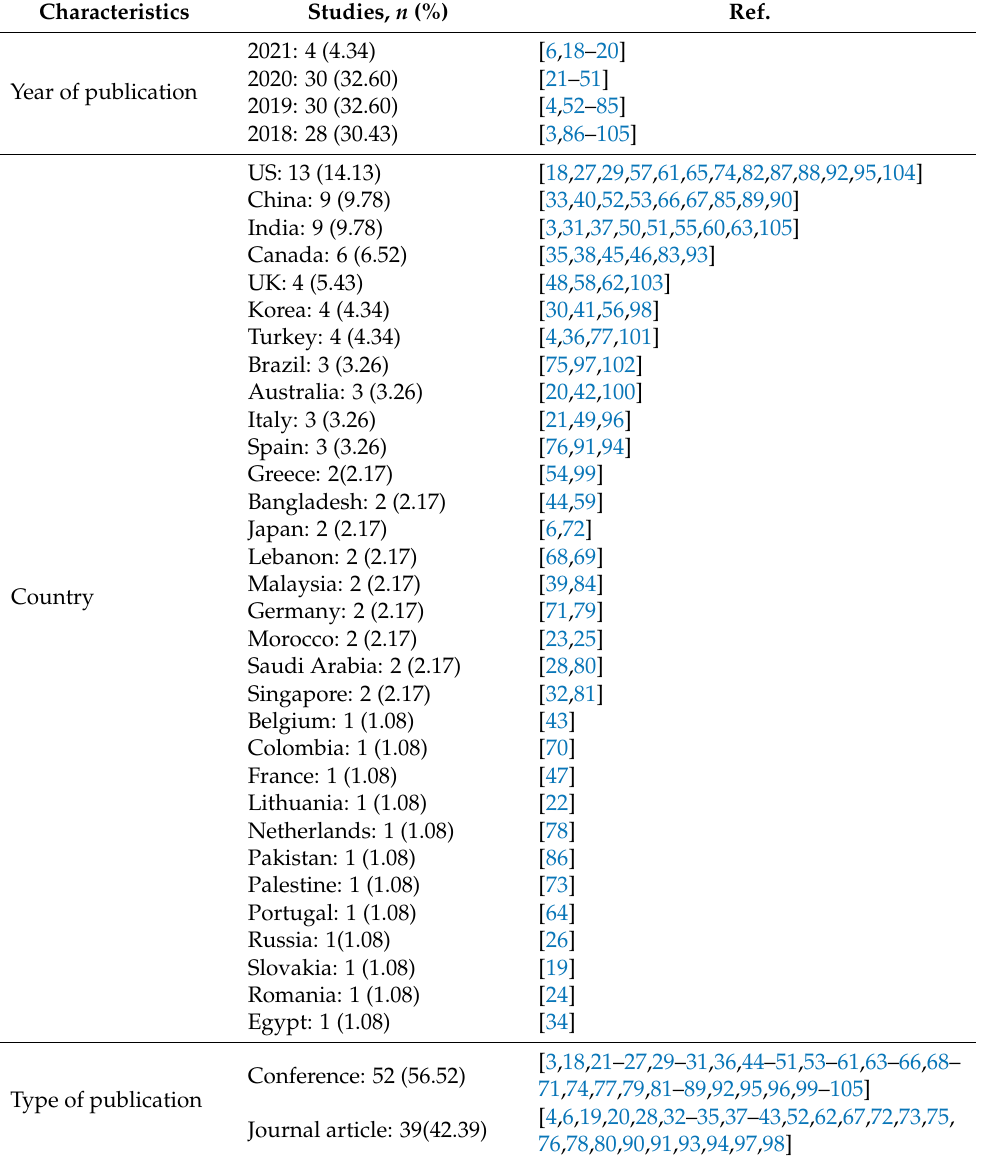
Table 2. General characteristics of the included studies ( n =